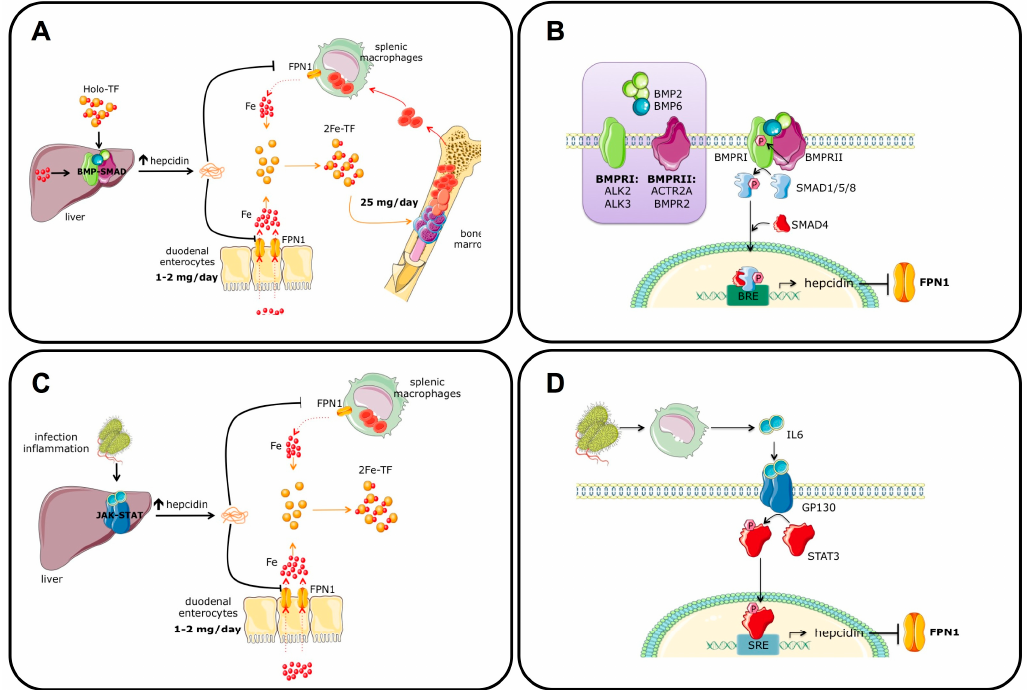
Figure 3. Regulation of systemic iron homeostasis by iron and inflammation. Dietary iron is absorbed by duodenal enterocytes and enters the circulation through the iron exporter ferroportin (FPN1). Iron circulates bound to transferrin and is internalized through the TF-TFR1 mechanism (Figure 1) by organs and tissues, mainly by erythroid cells for hemoglobin synthesis. Excess iron cannot be actively excreted and is safely stored in the liver and in reticuloendothelial macrophages of the spleen. Phagocytosis of senescent red blood cells and hemoglobin degradation by macrophages provide most of the iron utilized for hemoglobin synthesis. The liver regulates the amount of circulating iron to prevent the formation of non-transferrin-bound iron (NTBI) through hepcidin, a hormone that binds and blocks FPN1 function. Hepcidin expression and synthesis are increased by iron ( A ) and inflammation ( C ) to reduce iron entry into the bloodstream. ( B ) Mechanism of hepcidin regulation by the BMP-SMAD pathway. In the presence of BMP2/6, the constitutively active BMP type II receptors (BMPRII) phosphorylate and activate BMP type I receptors (BMPRI). BMPRIs then phosphorylate regulatory SMAD proteins such as SMAD1/5/8. Once phosphorylated, they interact with SMAD4 for nuclear translocation, where the complex recognizes BMP-Responsive Elements (BREs) in the promoter region of hepcidin. ( D ) Macrophage-derived IL6 binds to its receptor GP130 in hepatocytes and activates the JAK2-STAT3 signaling pathway: phosphorylated STAT3 translocates into the nucleus to bind the STAT3-responsive element (SRE) on the hepcidin promoter and activates its expression. Panels ( B , D ): adapted with permission from Ref. [46]. License date: 15 February 2023;